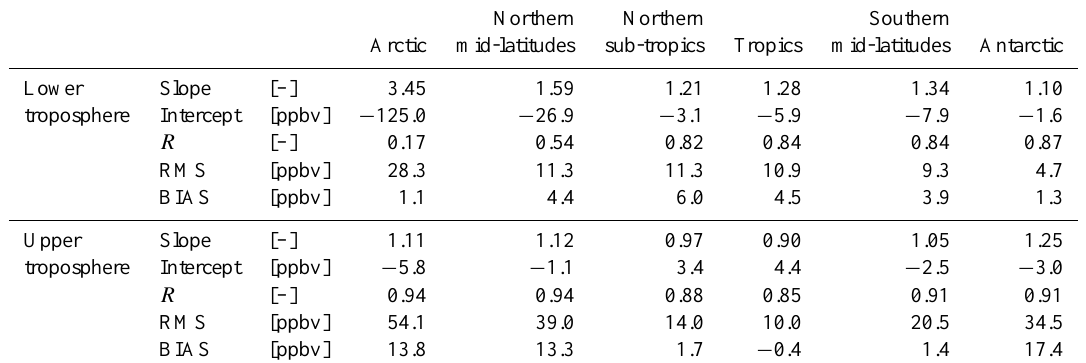
Table 1. Overview of the correlation between TES and sonde O 3 for the lower and the upper troposphere for different zonal bands. The slope, intercept, R , RMS and bias of the reduced major axis regression are provided. Northern Northern Southern Arctic mid-latitudes sub-tropics Tropics mid-latitudes Antarctic Lower Slope [–] 3.45 troposphere Intercept −